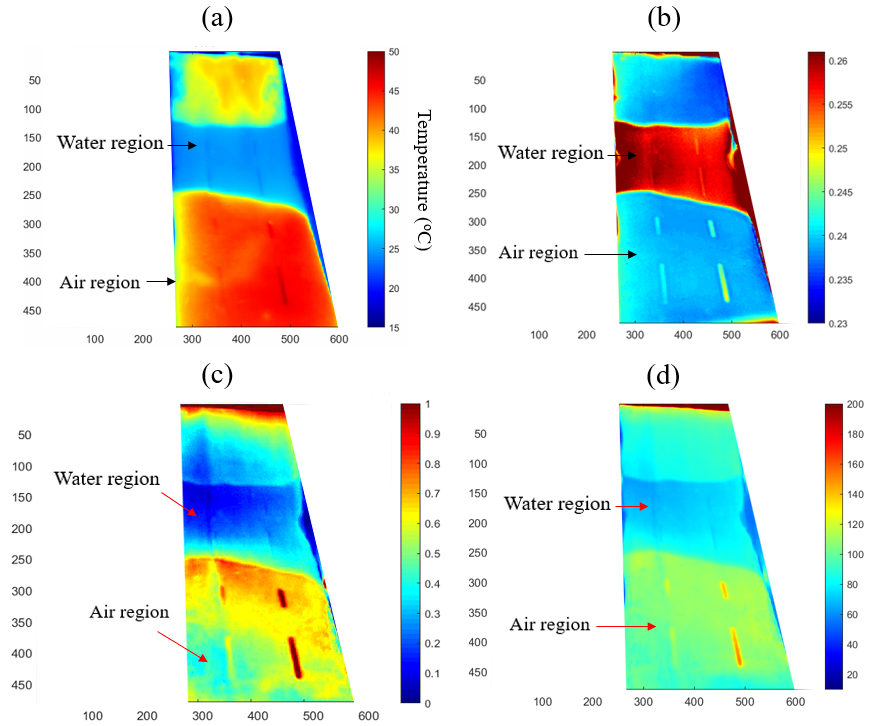
Figure 7. Results of analysis of thermal image sequences with different methods: ( a ) a single frame of the raw thermal image, ( b ) cooling constant map based on Newton’s cooling law analysis, ( c ) peak logarithmic second derivative method, and ( d ) frame subtraction method.